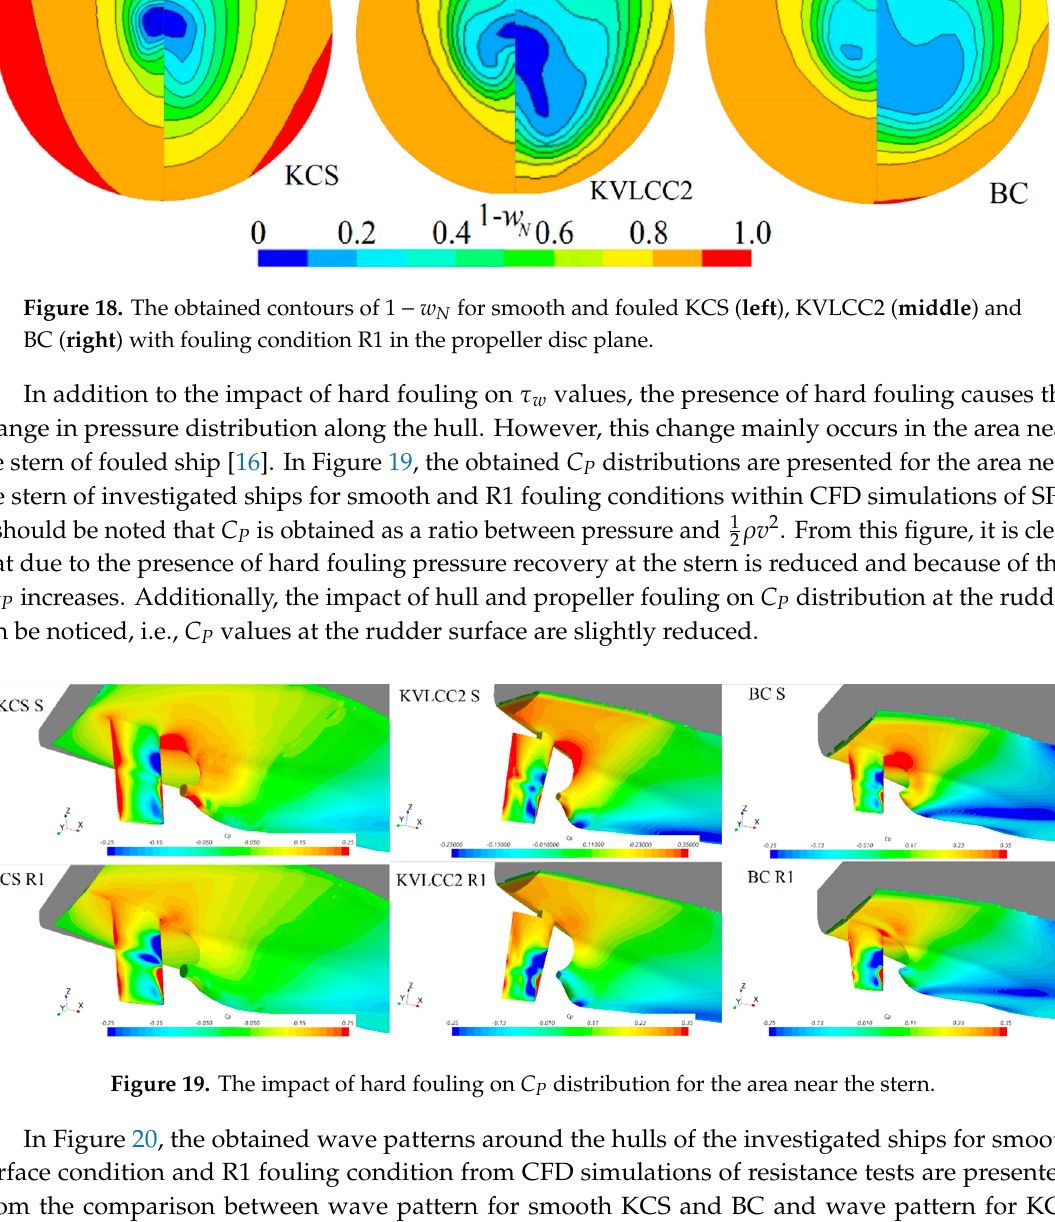
Figure 20. The obtained wave patterns around KCS ( left ), KVLCC2 ( middle ) and BC ( right ). 6. Conclusions In this paper, the impact of hard fouling on ship performance for three different ship types is investigated. This impact is investigated using the CFD simulations of resistance, open water and self-propulsion tests. The impact of hard fouling is represented through the modification of wall function, i.e., through the implementation of the Grigson